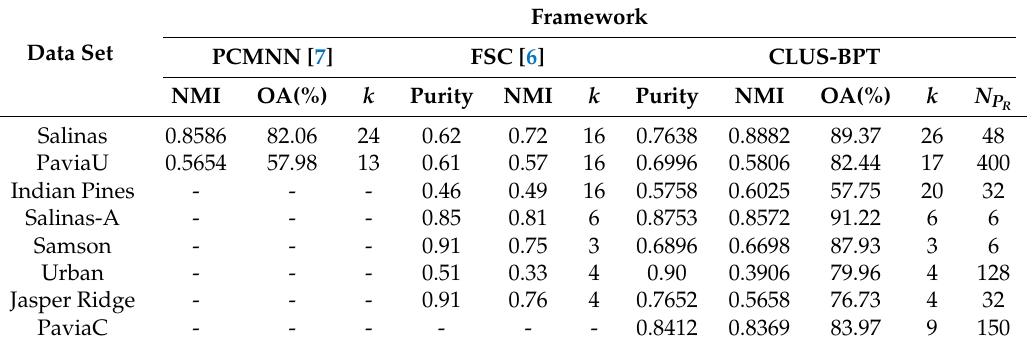
Table 2. Evaluation of clustering performance for HSI data